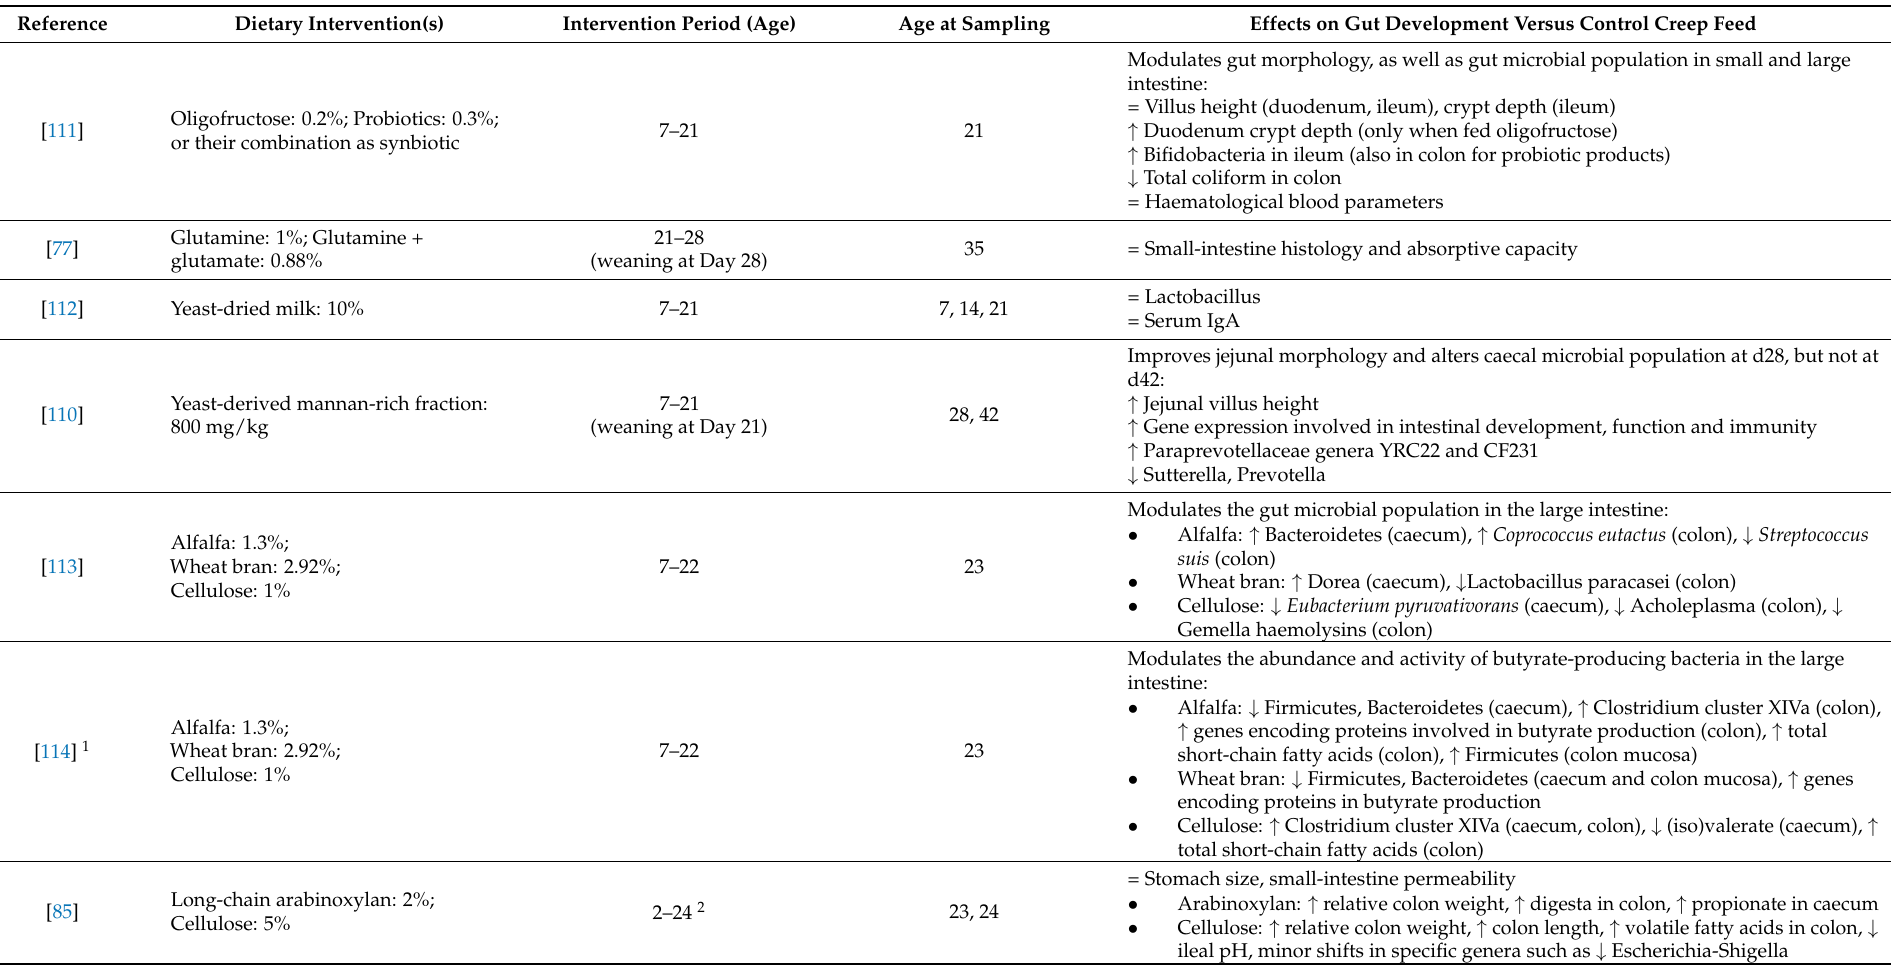
Table 3. Effects of pre-weaning dietary interventions through creep feed on the gut development of sow-reared piglets. ↓ Significant decrease at p < 0.05; ↑ Significant increase at p < 0.05; = No significant